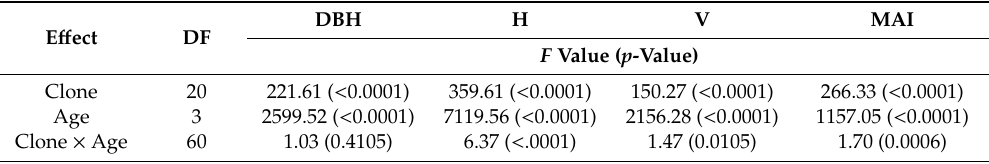
Table 2. Results of the generalized linear mixed model (GLIMMIX) analysis of growth traits of aspen clones: Type III tests of fixed effects.